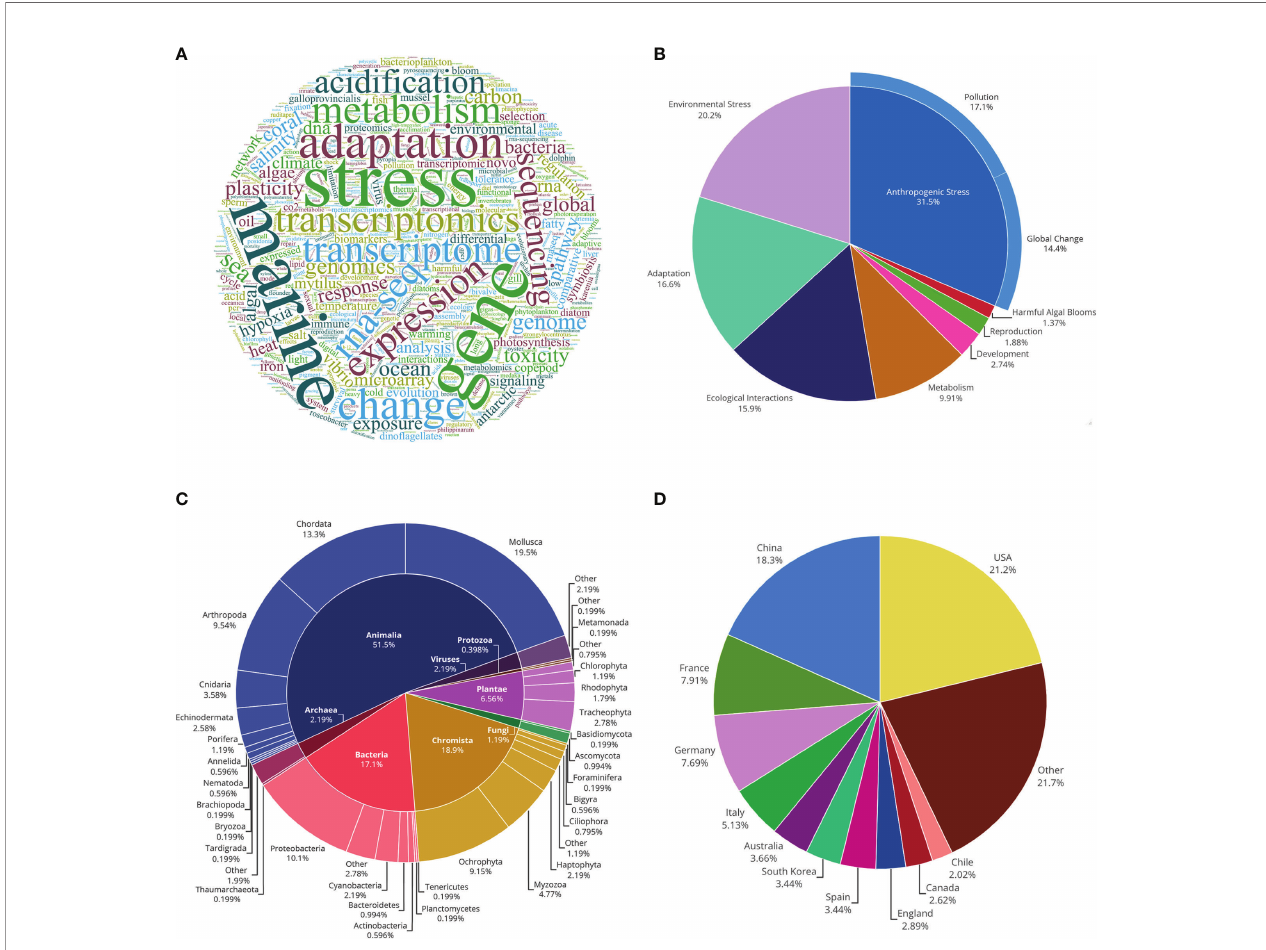
FIGURE 2 | Trends in marine ecological studies using transcriptomics. (A) Word cloud of author keywords, where size of words is proportional to their frequency; (B) Frequency of manually assigned topics; (C) Taxonomic classi fi cation of studied organisms, with the inner circle representing kingdom and the outer circle phylum ( ‘ Other ’ represents cases when the phylum could not be identi fi ed based on information given, such as studies involving organisms from multiple kingdoms); (D) Geographical spread of the research based on countries of author institutions ( ‘ Other ’ represents countries with less than 2% representation). See Supplementary Tables 1, 2 for more